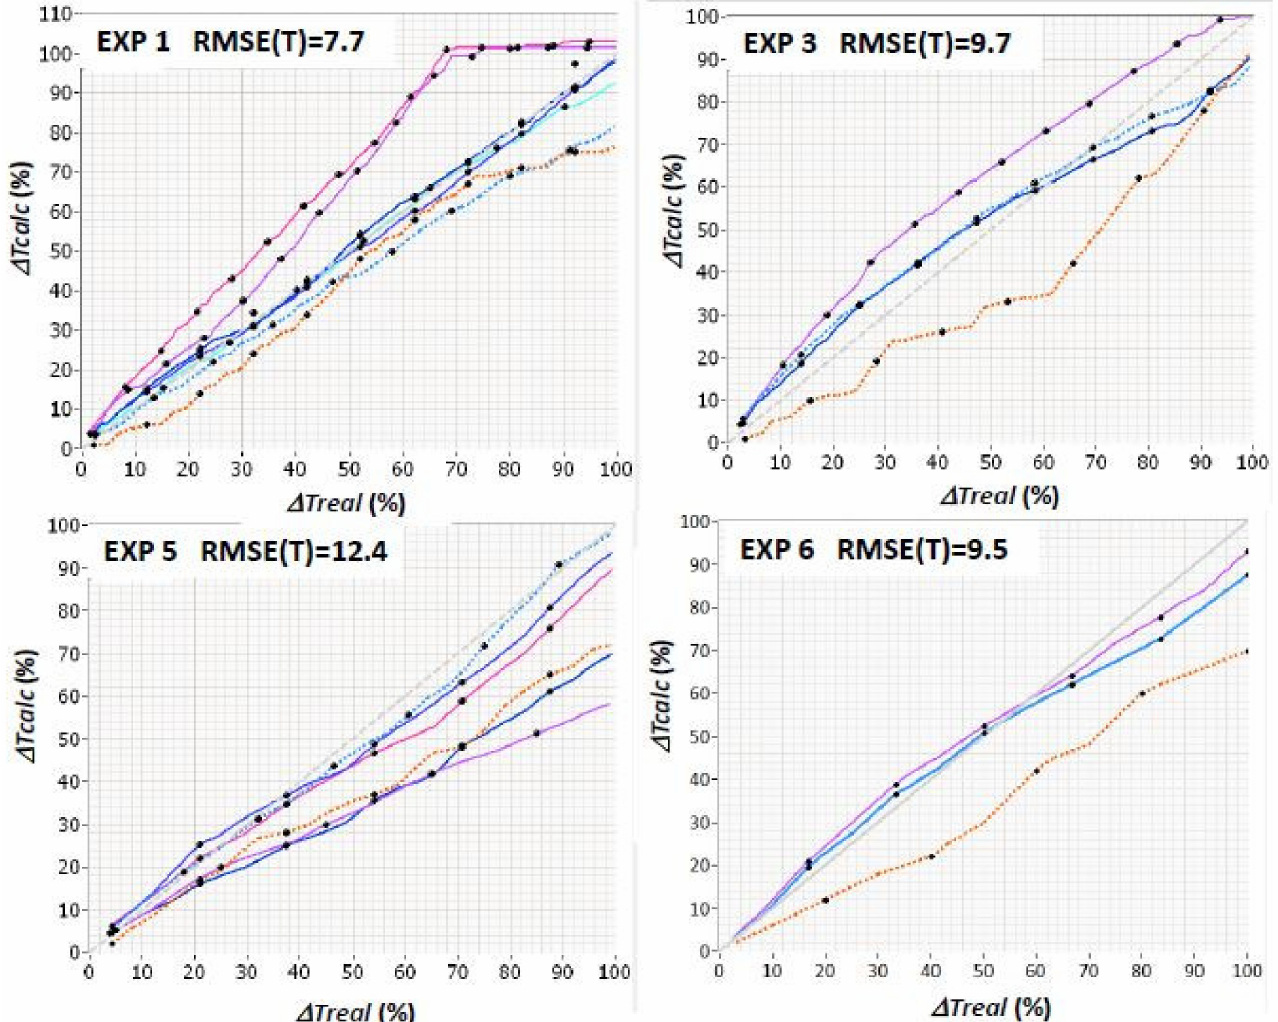
Figure 8. Estimated toollife from learning on selected signal